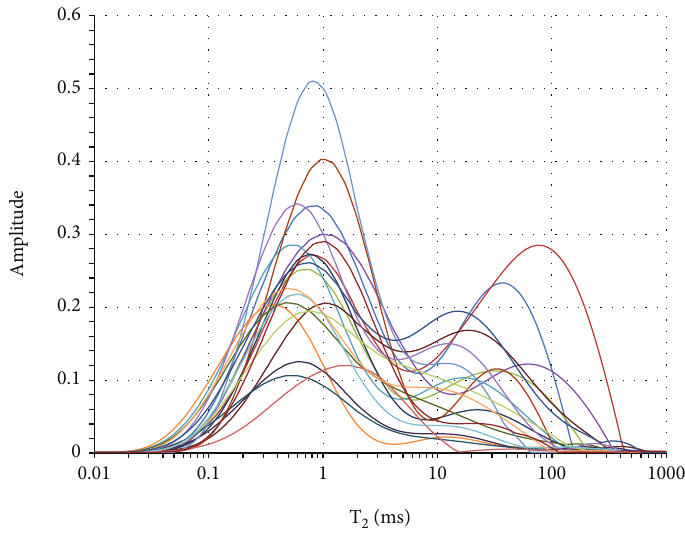
Figure 6: NMR T spectra of Chang 8 reservoir in the Pengyang area. 2